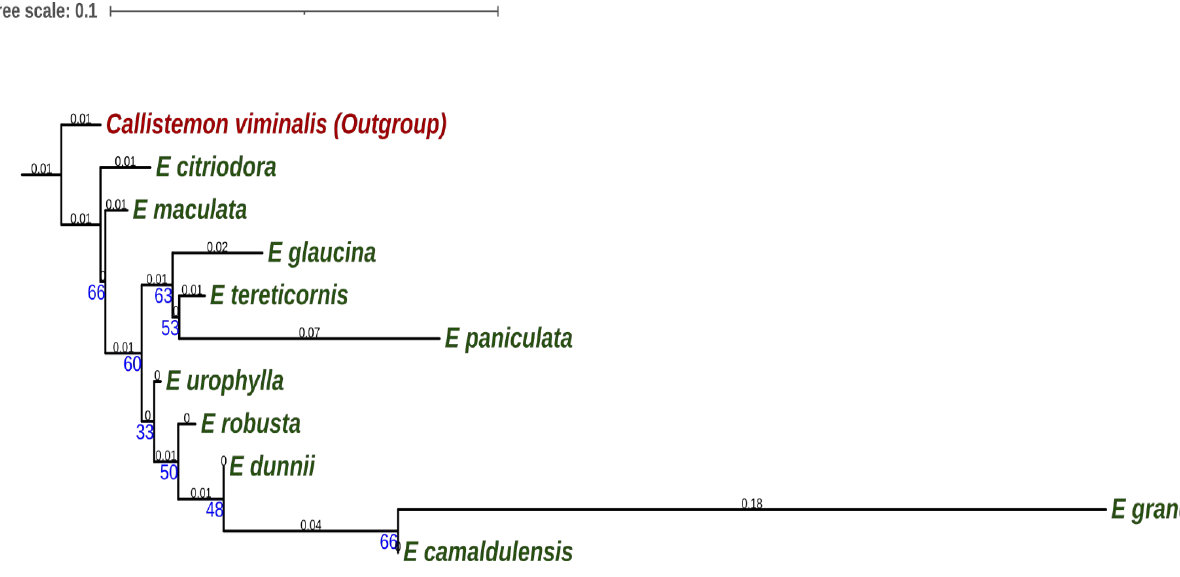
Figure 5. Concatenated sequence phylogenetic tree. (Bootstrap support values are shown at the nodes; values above 70 indicate that the tree topology/monophyletic clade is strongly supported; values around 50 indicate moderate support while value below 50 indicate poor support).